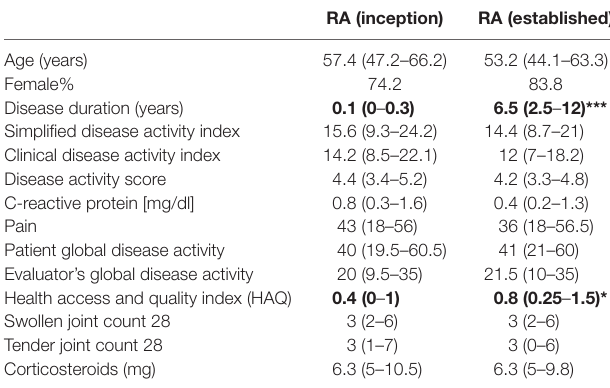
TaBle 1 | Descriptive characteristics of rheumatoid arthritis (RA)